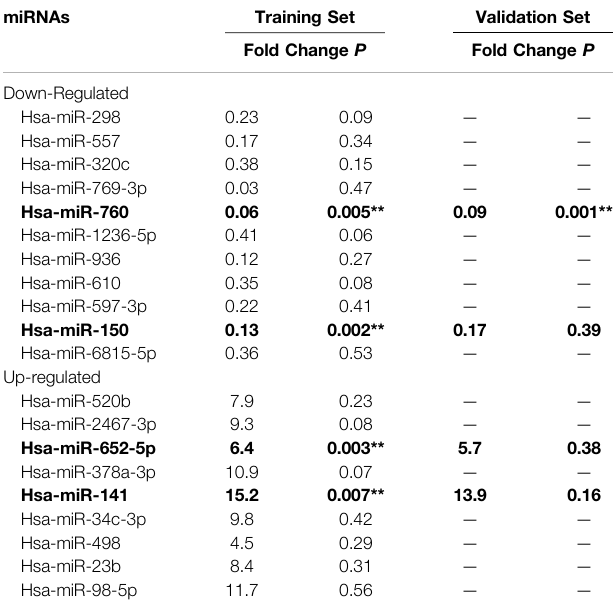
TABLE 1 | Differentially expressed miRNAs in NP tissues from IDD and controls. miRNAs Training Set Validation Set Fold Change P Fold Change